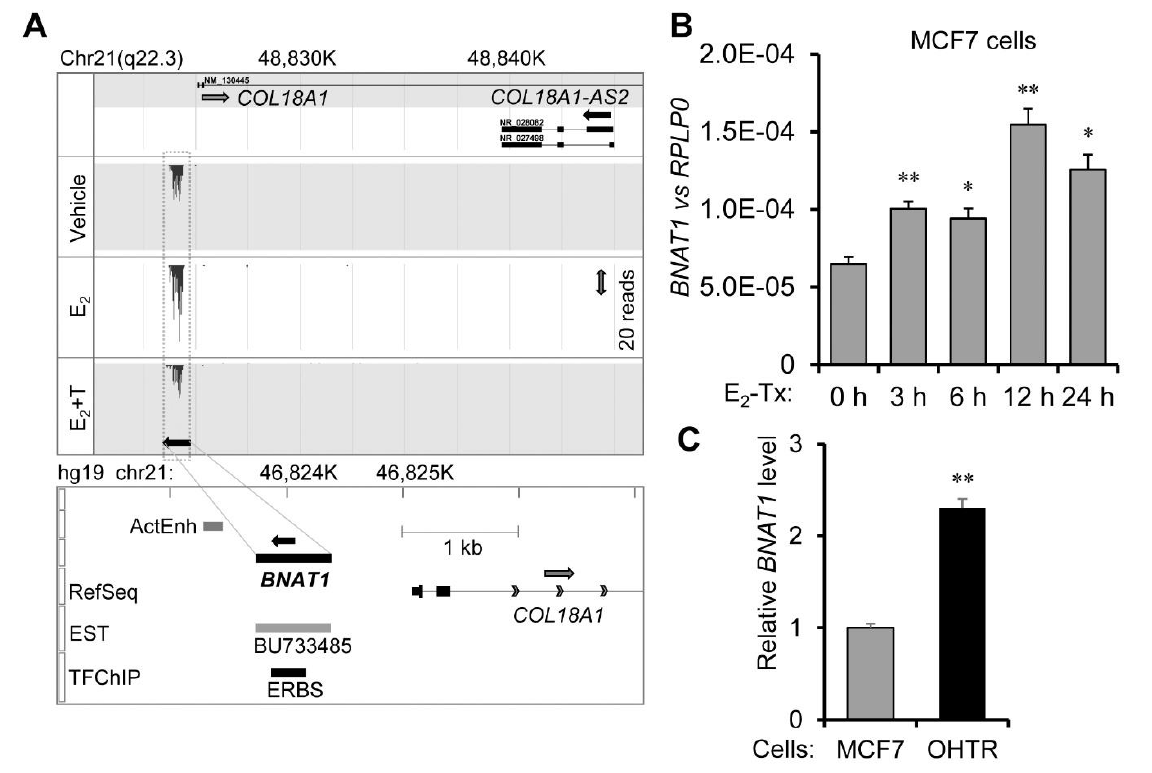
Figure 1. Estrogen-inducible lncRNA breast cancer natural antisense transcript 1 ( BNAT1 ) is transcribed from the promoter region of COL18A1 and expressed in estrogen receptor (ER)-positive breast cancer cells. ( A ) Mapping of RNA-seq read tags from MCF7 cells to the antisense strand adjacent to the COL18A1 locus in chromosome 21q22.3. BNAT1 expression was enhanced in MCF7 cells with 17 β -estradiol (E 2 , 100 nM) treatment for 4 h in comparison to vehicle or E 2 (100 nM) + T (OH-tamoxifen, 1 µM) treatment for 4 h. ActEnh, a cluster region including at least three E 2 -upregulated active enhancers (previously defined in MCF7 cells by refs. [6–8], n = 1248) with a distance between two adjacent enhancers ≤ 25 kb. Detailed information is described in Table S1. ERBS, a functional ER-binding site (ERBS) defined by the ENCODE dataset of ChIP-seq in E 2 -treated endometrial cancer ECC cells (GEO accession number: GSM803422). ( B) E 2 (100 nM)-dependent upregulation of BNAT1 in MCF7 cells. ( C ) BNAT1 was overexpressed in OH-tamoxifen-resistant MCF7 (OHTR) cells compared with parental MCF7 cells. *, p <0.05; **, p